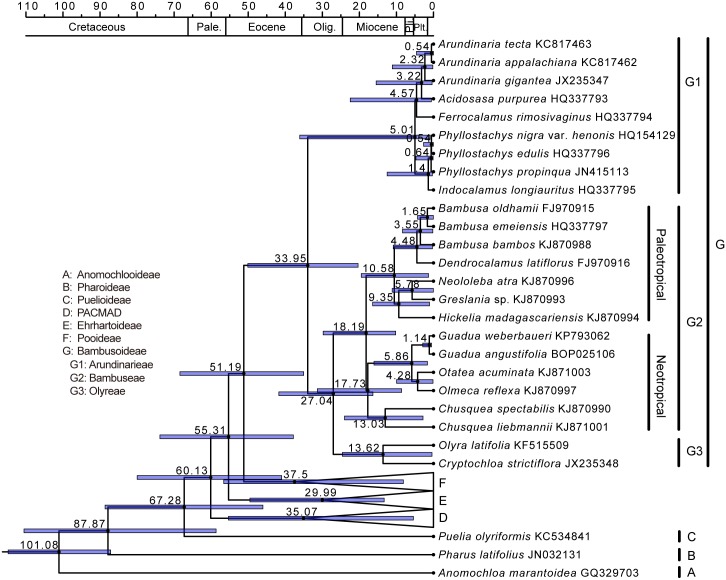
Bayesian chronogram for Bambusoideae and related subfamilies.Estimates of divergence times for major clades are listed near nodes and blue bars show the 95% highest posterior density (HPD) of relevant nodes. Pale., Paleocene, Olig., Oligocene, Pli., Pliocene, Plt., Pleistocene.